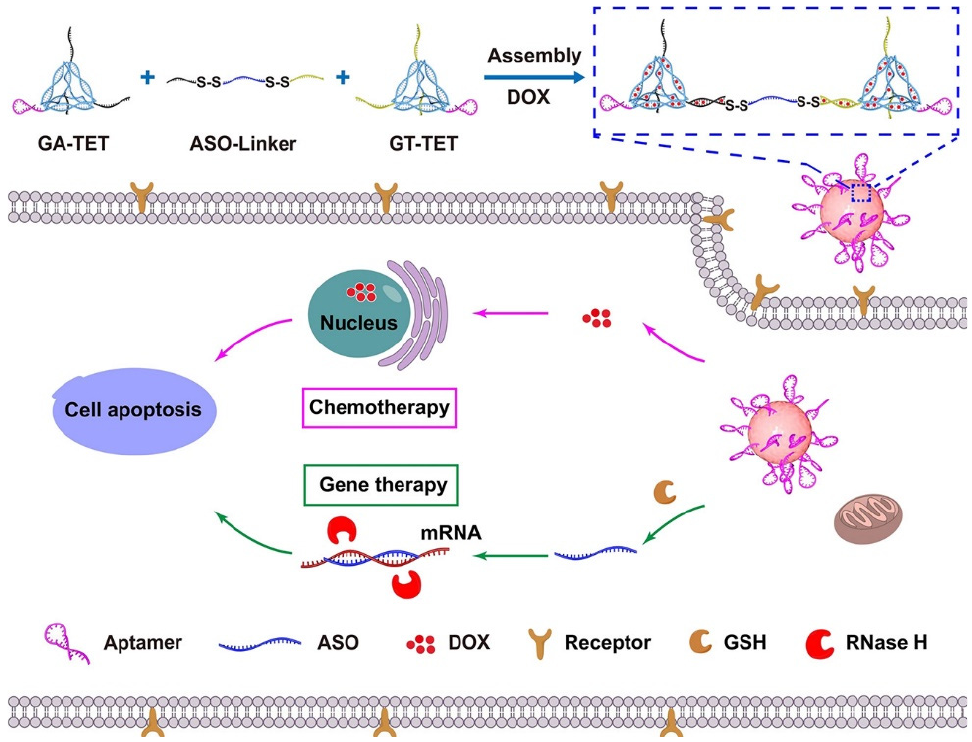
Figure 3. An aptamer-modified DNA tetrahedron-based NG for combined chemo/gene therapy of MDR tumors. Reproduced from Tang et al. [111] with permission from American Chemical Society, USA.